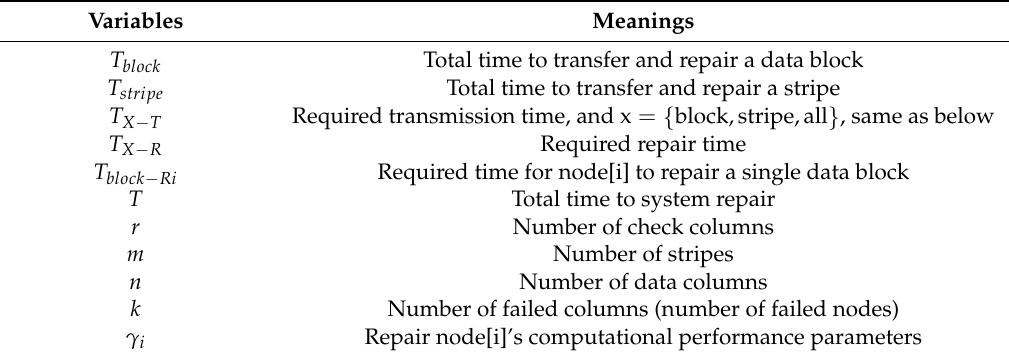
Table 1. Variables and their meanings in efficiency